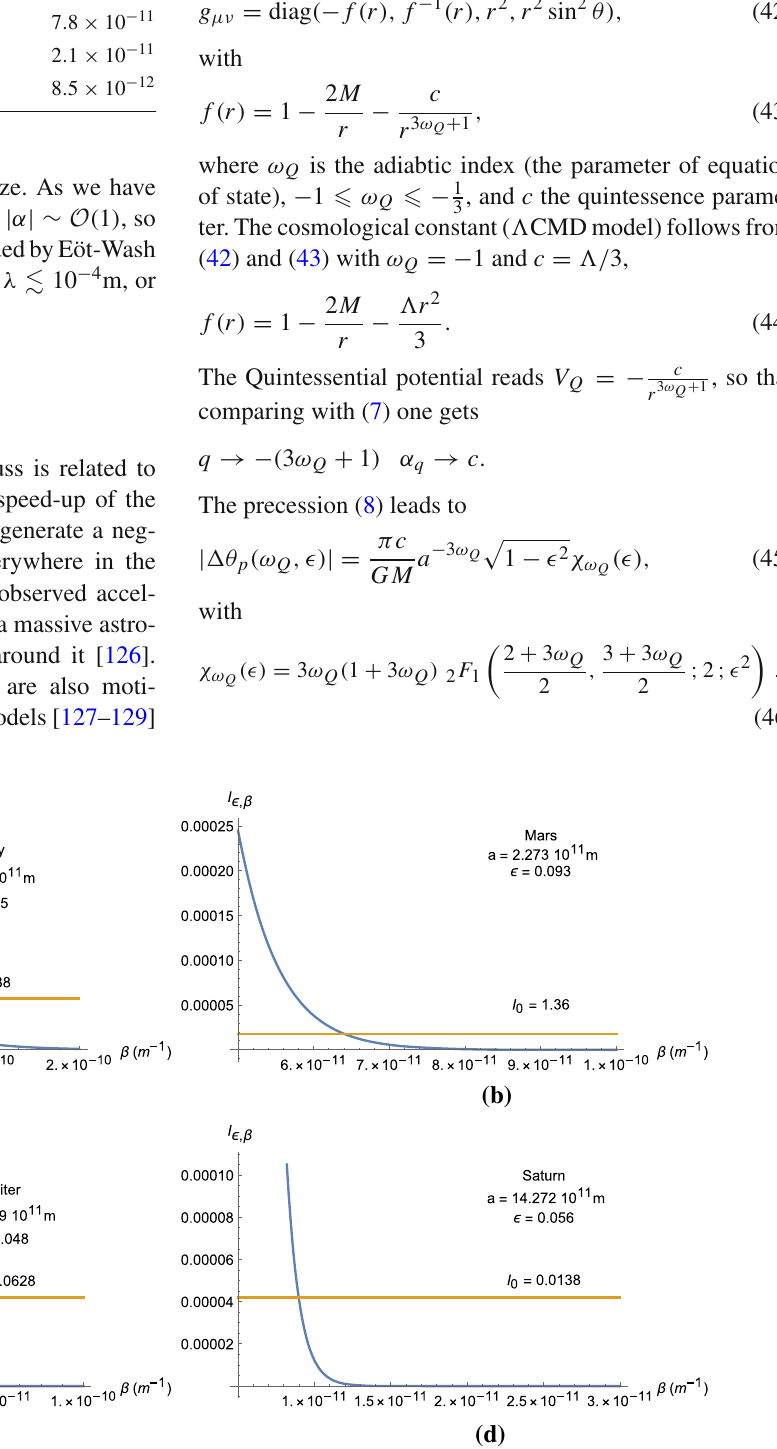
Table 4 Lower bounds on β obtained from (41) using the values of periastron advance for planets of the Solar System Planet η I 0 ≡ 3 η(cid:10) Mercury 0.5 0.038